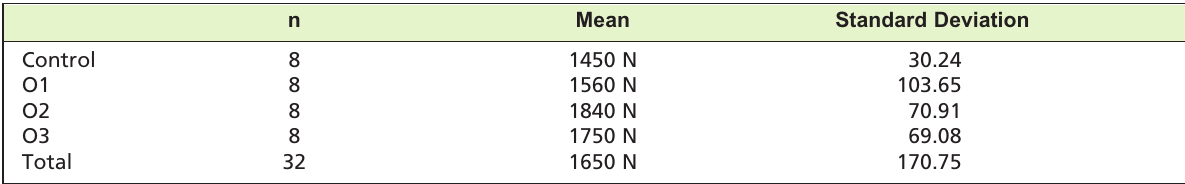
Average compressive strength in each group Table II: